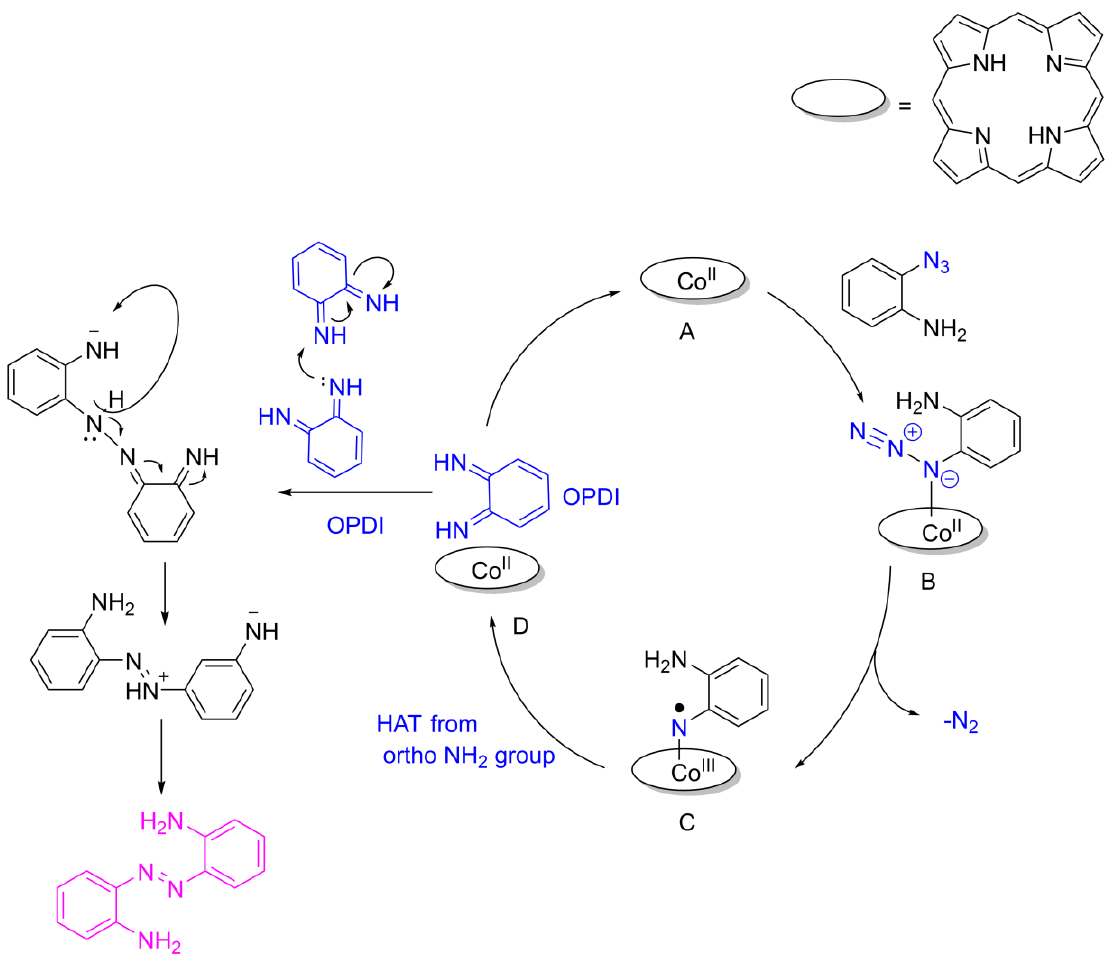
Scheme 3. Proposed mechanism of the Co(II) porphyrin-catalyzed route to o -amino-azobenzenes via o